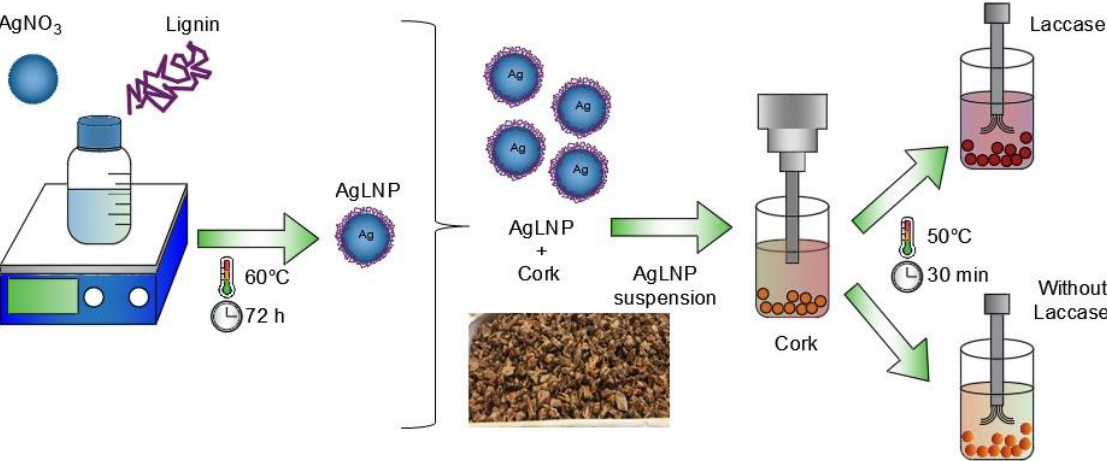
Figure 1. Synthesis and embedding of AgLNP in cork by the sonochemical technique.